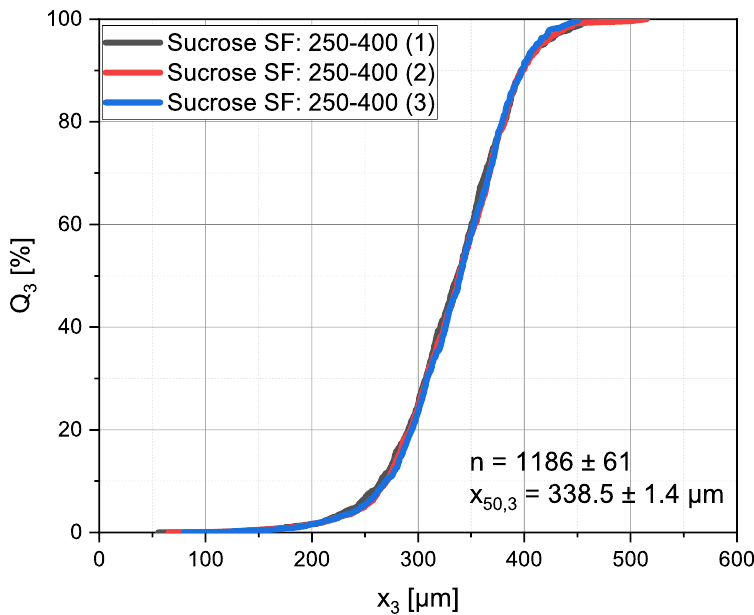
Figure 6. Q 3 distribution of the same sample measured and processed three times. The sample was taken from, and put back into, the sampler between the measurements. For demonstration purposes, sucrose with a sieve fraction of 250–400µm, was